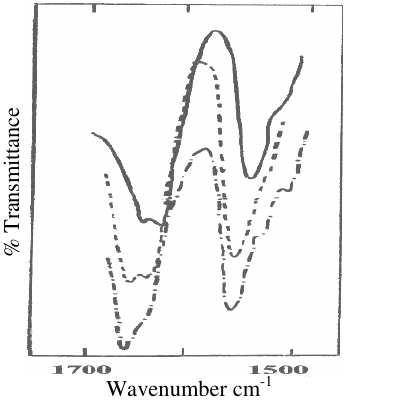
Figure 2. CD Spectra of γ - benzyl- L - glutamate and L - valine copolypeptides, -; n=13, -.-; n= 30, -..-; n=